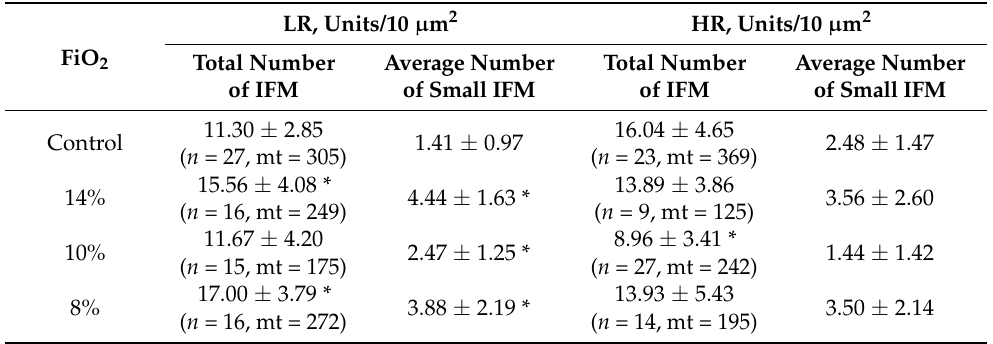
Total Number Average Number of IFM of Small IFM 16.04 ± 4.65 2.48 ± 1.47 ( n = 23, mt = 369) 13.89 ± 3.86 3.56 ± 2.60 ( n = 9, mt = 125) 8.96 ± 3.41 * 1.44 ± 1.42 ( n = 27, mt = 242) 13.93 ± 5.43 3.50 ± 2.14 ( n = 14, mt = 195)